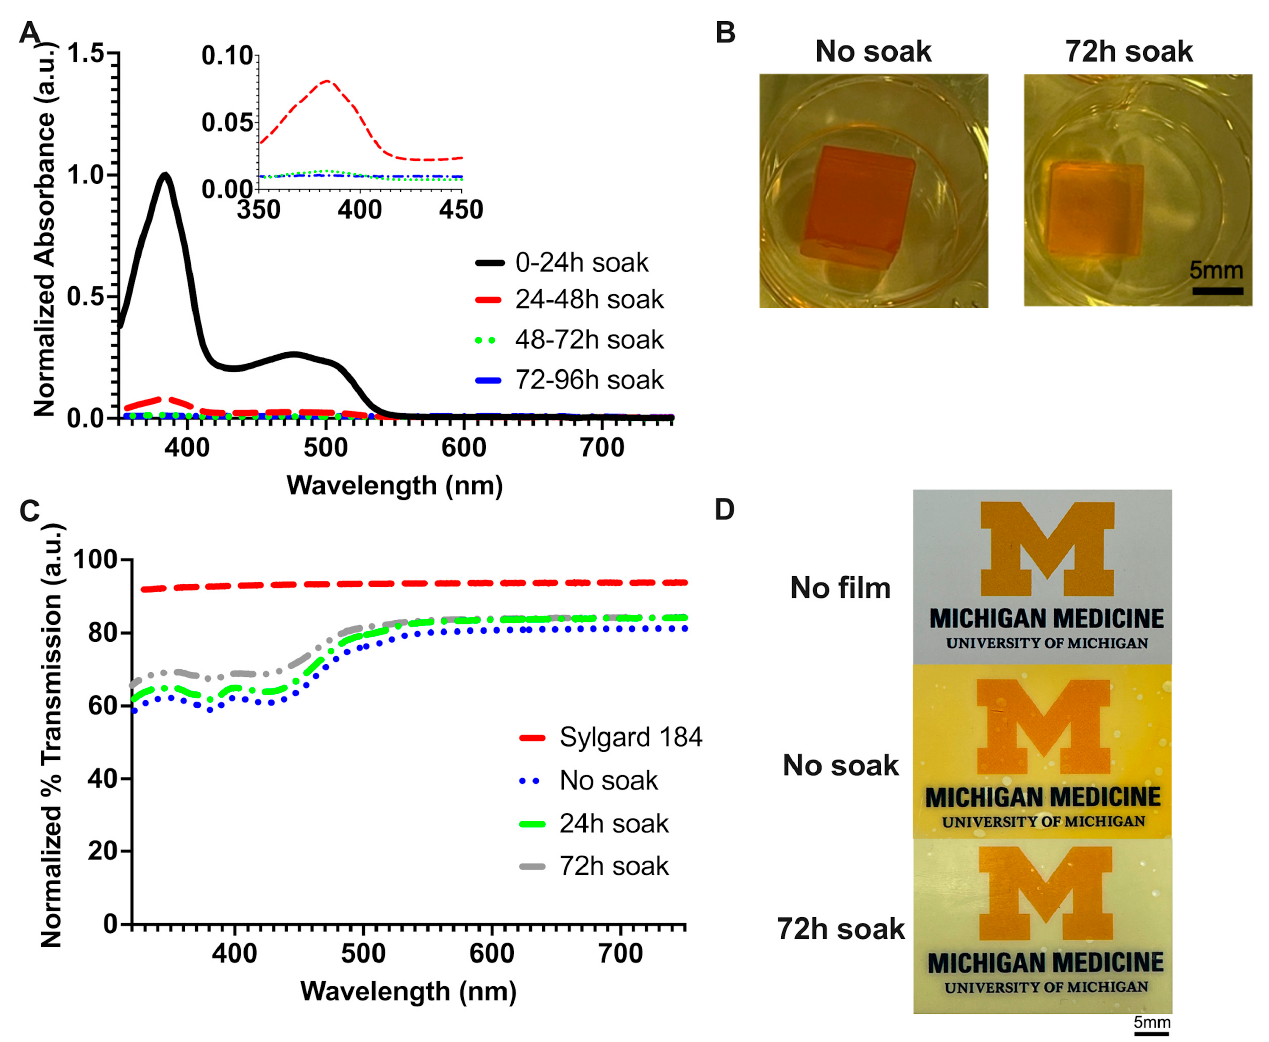
Figure 5. ( A ) Absorbance signal of extraction media after soaking 3D-printed part in EtOH ( n = 3), ( B ) comparison of the color loss from a cube that was extracted with EtOH (72 h soak) to one that was not extracted (no soaking), ( C ) transmission data of 100 µm thin films after extraction with EtOH ( n = 3), and ( D ) optical clarity of films after 72 h of EtOH extraction relative to no soak (no EtOH extraction) and no film (original image of Michigan Medicine logo) treatments.